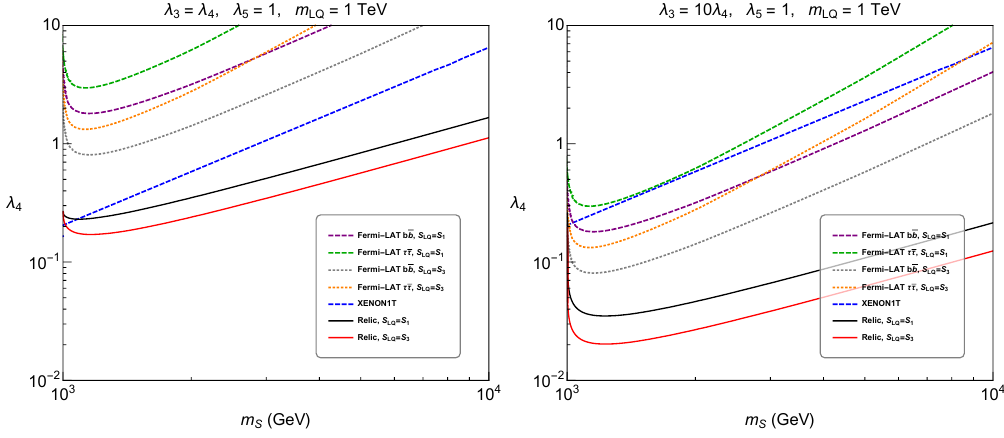
Figure 8 . Relic density for scalar dark matter and various bounds in the parameter space, (cid:21) 4 vs m S . The correct relic density can be obtained along the black and red solid lines, for models with singlet and triplet scalar leptoquarks, respectively. XENON1T bounds are shown in blue dashed lines. Fermi-LAT gamma-ray constraints on b (cid:22) b and (cid:28) (cid:22) (cid:28) coming from cascade annihilations are also shown in purple dashed (gray dotted) and green dashed (orange dotted) lines for singlet (triplet) leptoquarks.